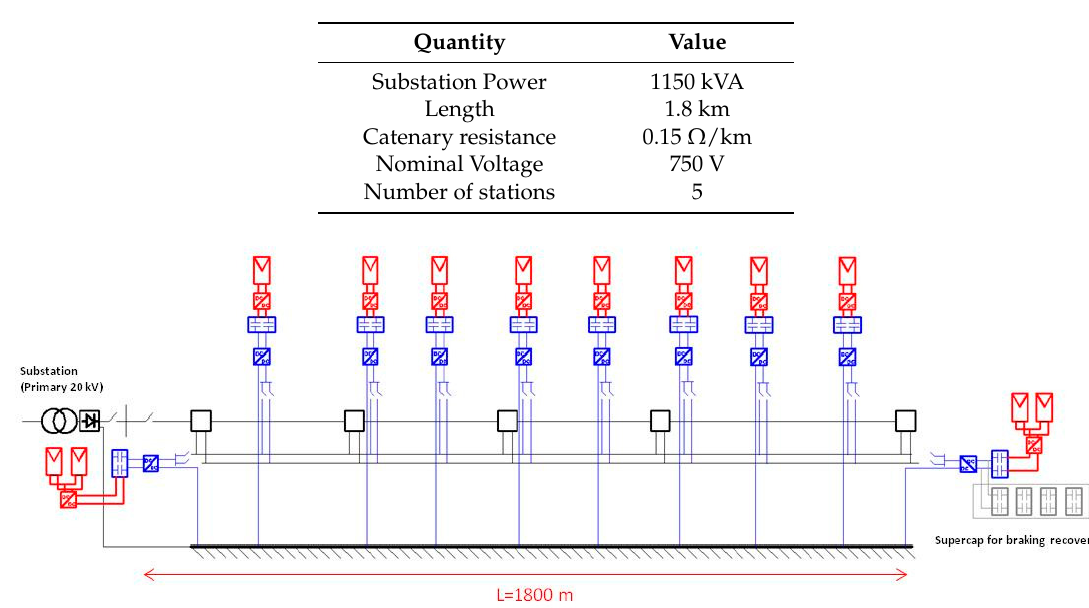
Figure 3. Electric layout of the railway power system for the considered track: integration of photovoltaic modules and of storage systems in the circuit.